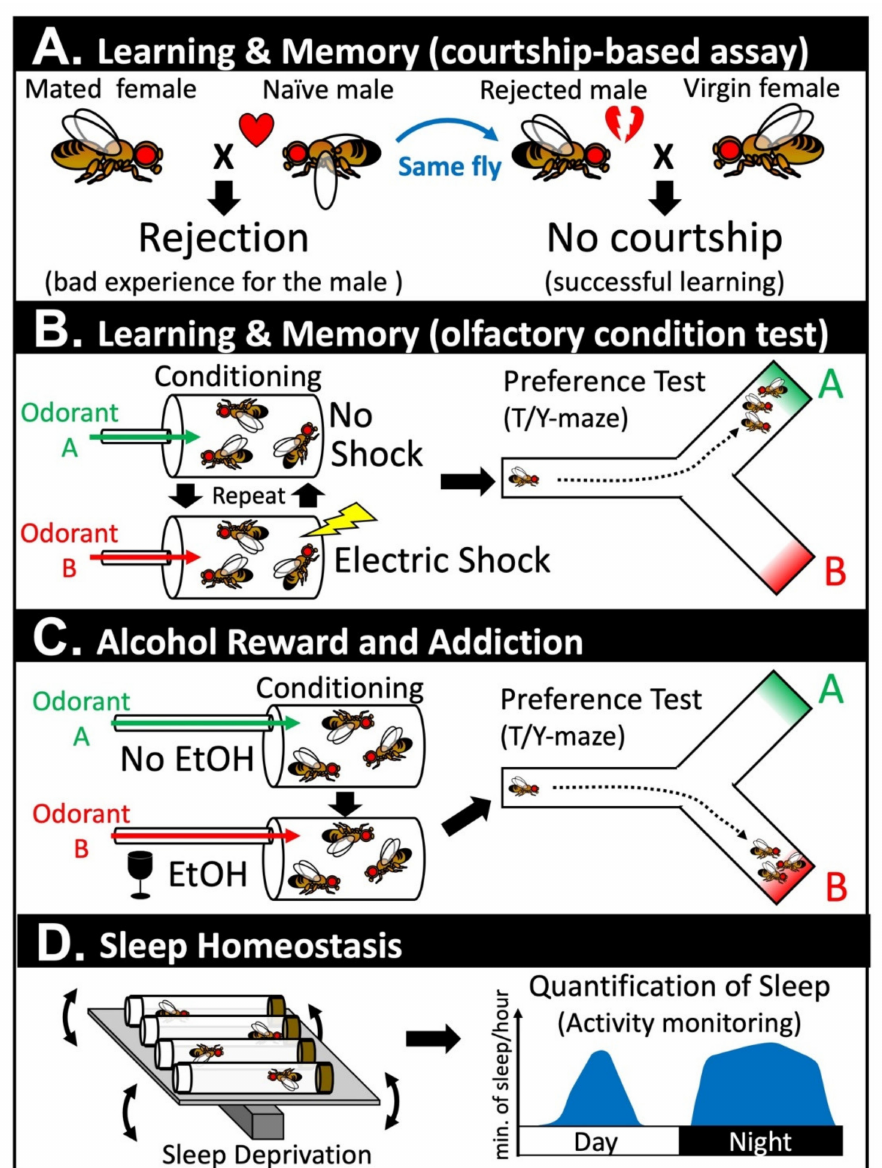
Figure 1. Assays in Drosophila that have been used to assess post-developmental functions of Notch signaling in the adult nervous system. ( A ) Learning and memory can be assessed via a courtship-based assay. Naïve male flies have a natural instinct to court female flies. A male will be successful if he courts a virgin female, but will be strongly rejected if he courts a mated female. Once rejected, the male fly learns from this unpleasant experience and will not attempt to court another female for a period of time even when paired with a receptive virgin female. ( B ) Learning and memory can also be assessed using an olfactory condition test. In this assay, a group of flies are presented with a neutral odorant (odorant A) and an odorant that is paired with an electric shock (odorant B). After repeating this training several times, the flies are then put into a T-maze or a Y-maze to assess whether they learned to avoid odorant B. These flies can be collected again and be further tested at a later timepoint to assess their ability